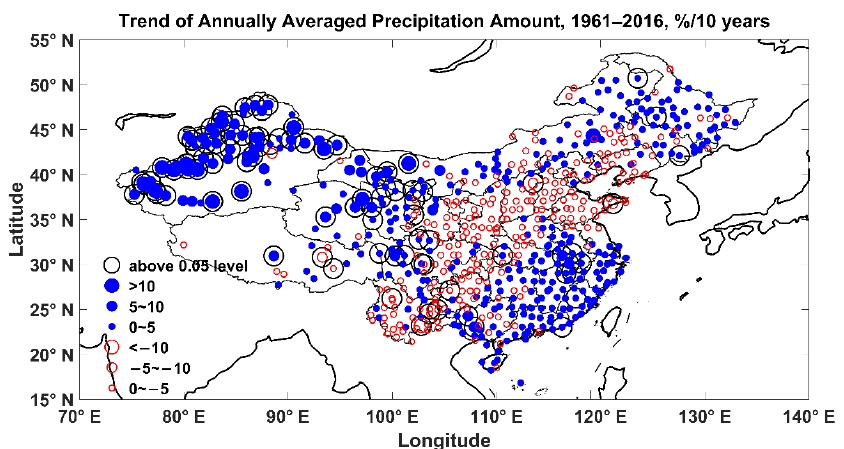
Figure 2. The decadal trend of the relative change of annually averaged precipitation for all examined 635 ground stations from 1961 to 2016.